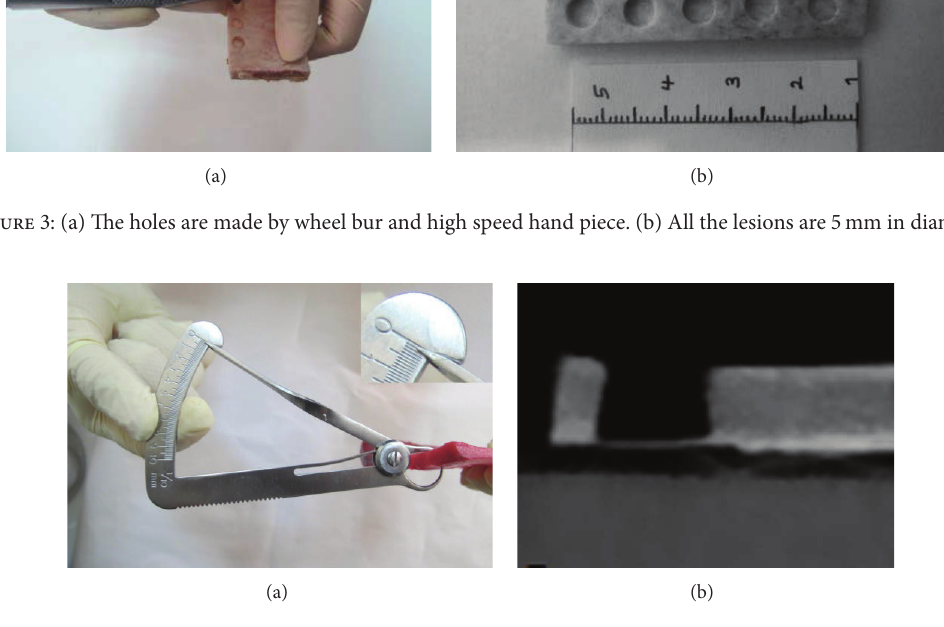
Figure 4: (a) The remaining cortical bone was measured by dental caliper (here in sample number 1 the thickness is 0.1mm). (b) In cross- sectional view of CBCT image, no perforation is found.